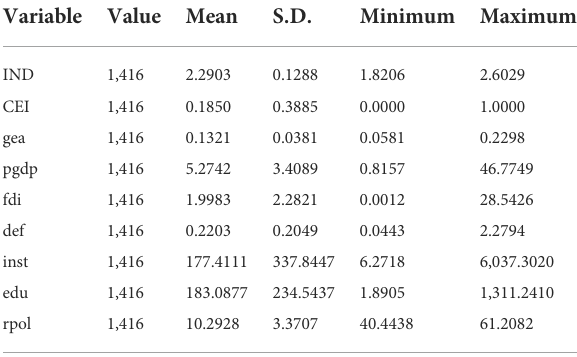
TABLE 2 Descriptive statistics of the main